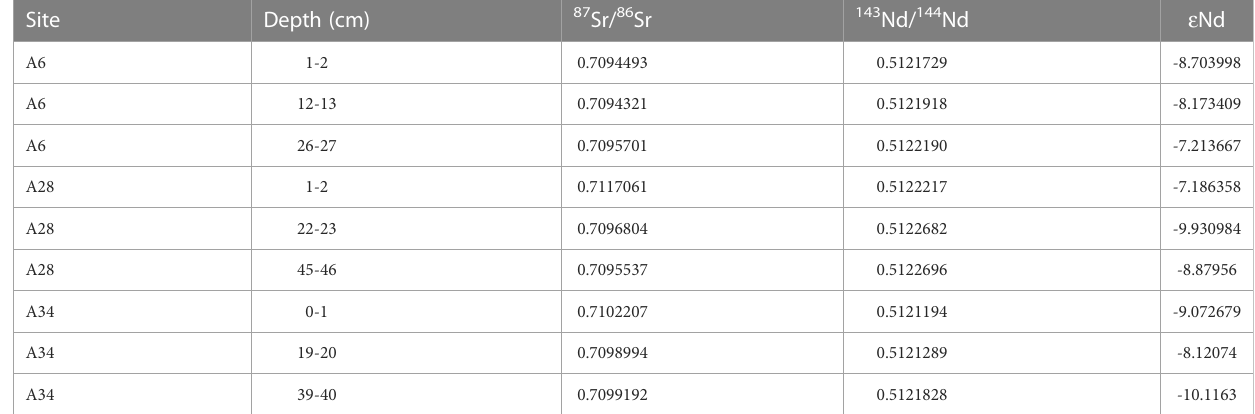
TABLE 2 The Sr-Nd isotope ratios of some core sediments in the